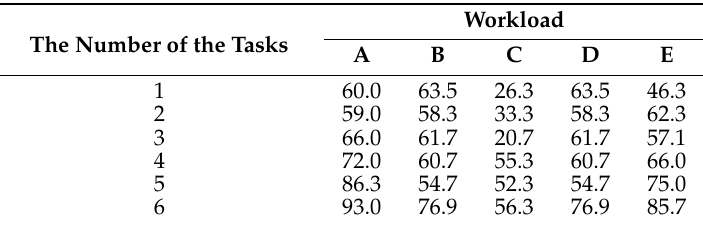
Table 1. Workload of the tasks for subjects A–E. The Number of the Tasks